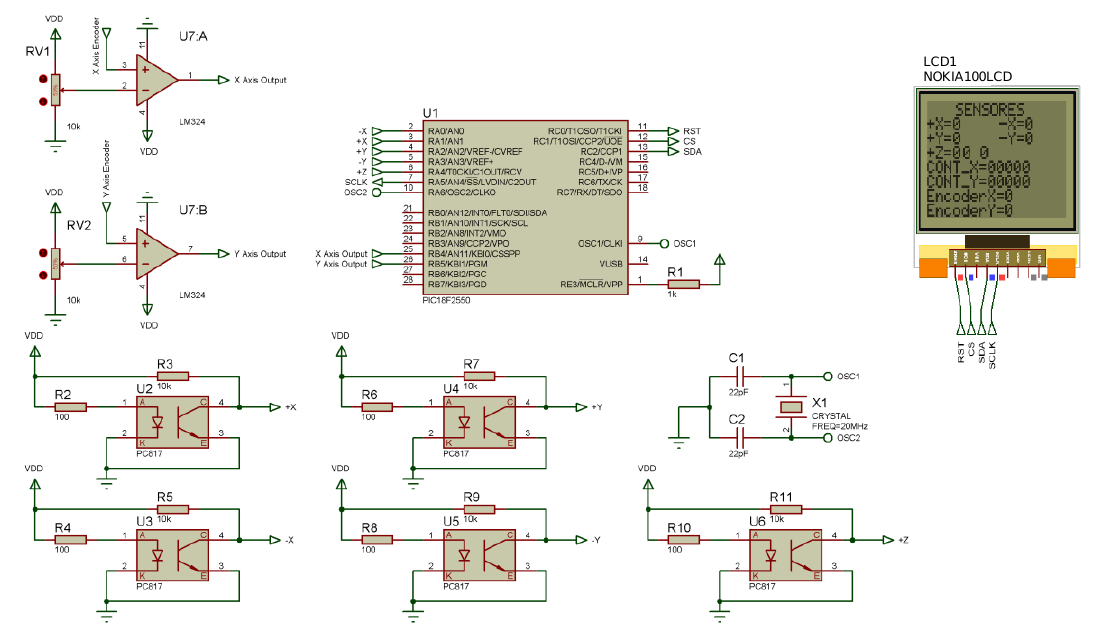
Figure 10. Schematic diagram of the monitoring stage.